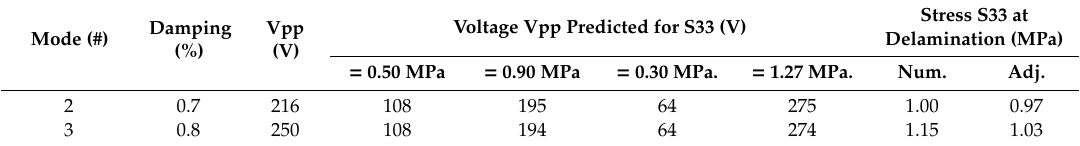
Table 17. Stress S33 and voltage prediction by the numerical model compared to experimental results for delamination